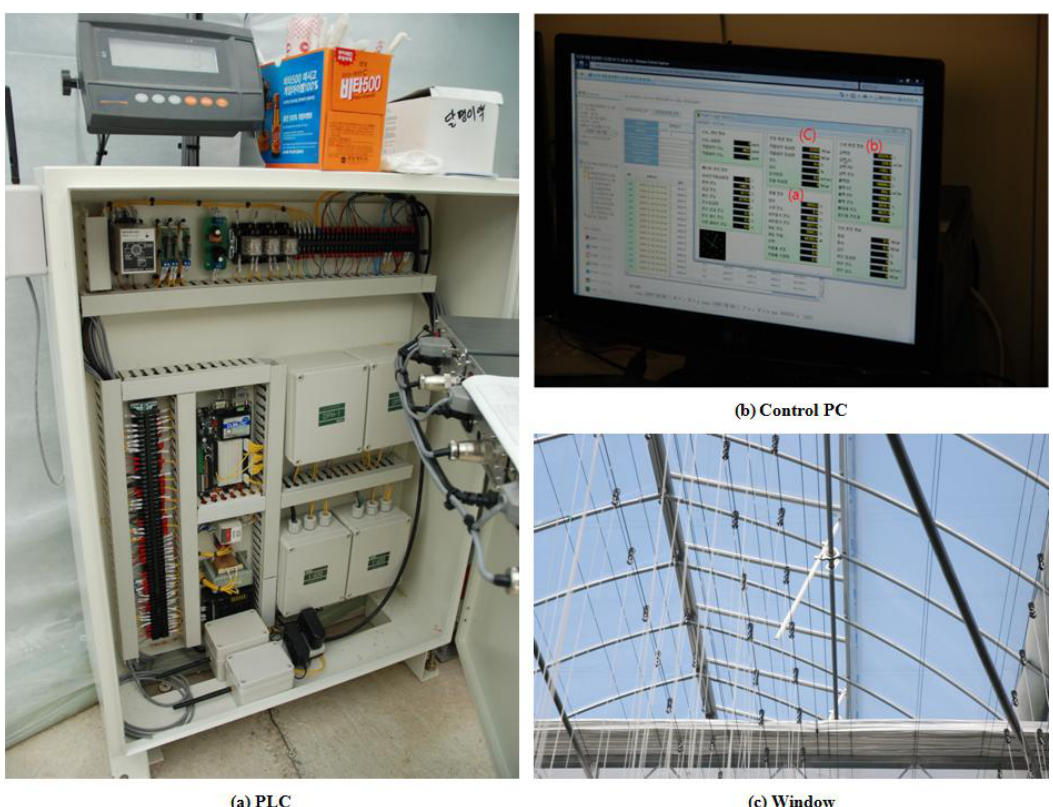
Figure 13. Environment Control Facilities and